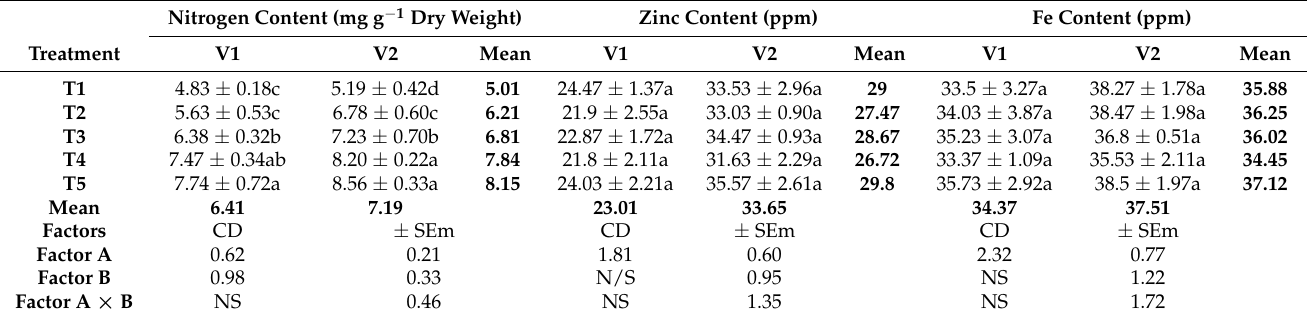
Table 8. Effect of different priming treatments on nitrogen, zinc, and iron